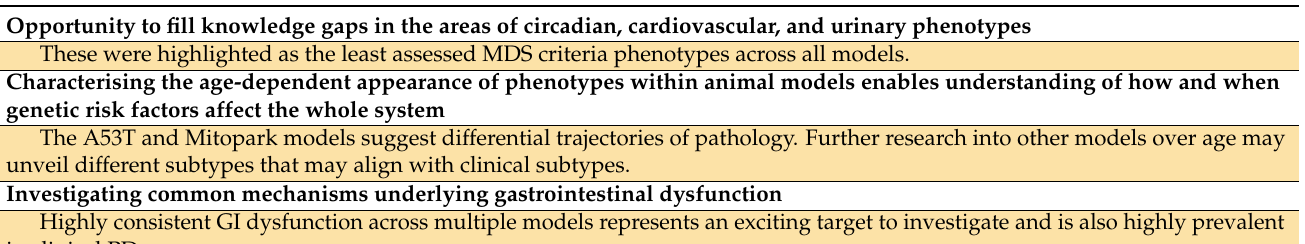
Table 2. Summary highlight of recommendations and